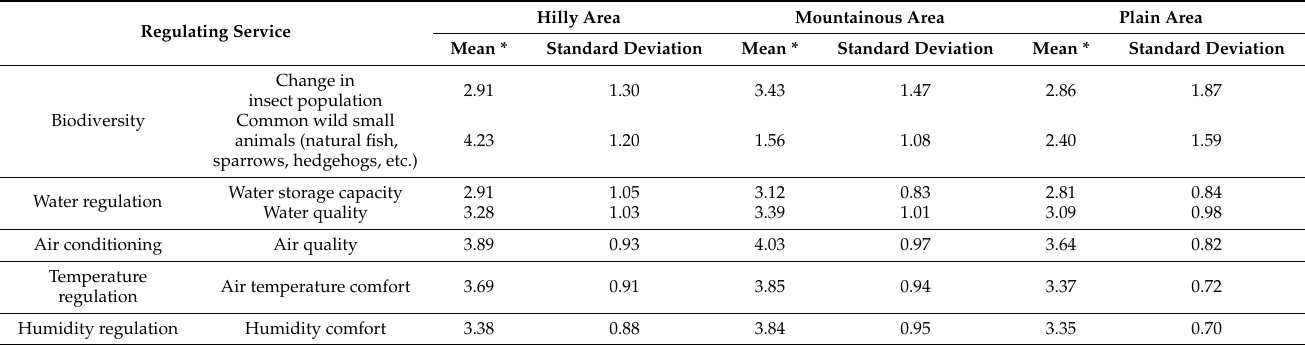
Table 7. Perception measures of regulating service in three topographic areas.